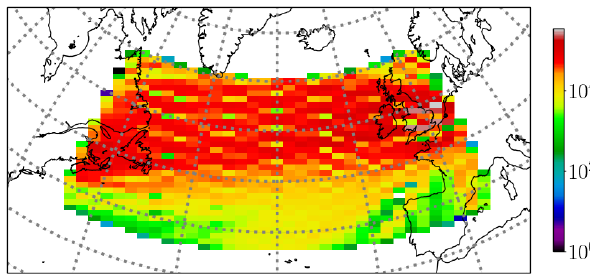
Figure 1. Number of IAGOS measurements per grid box (2 ◦ in lon- gitudinal and 0.57 ◦ in latitudinal directions) during 1 January 2000 to 31 December